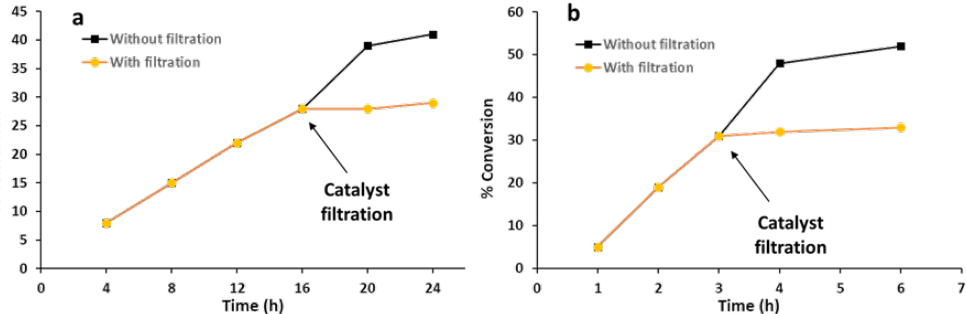
Figure 10. Heterogeneity test for oxidation of ( a ) benzyl alcohol and ( b ) styrene Conversion is based on the substrate ( a benzyl alcohol/ b styrene); TBHP (0.15 mmol); temperature ( a 90 °C/ b 80 °C); O 2 balloon 1 atm; amount of Co/TSA-ZrO 2 ( a 100 mg/ b 150 mg).